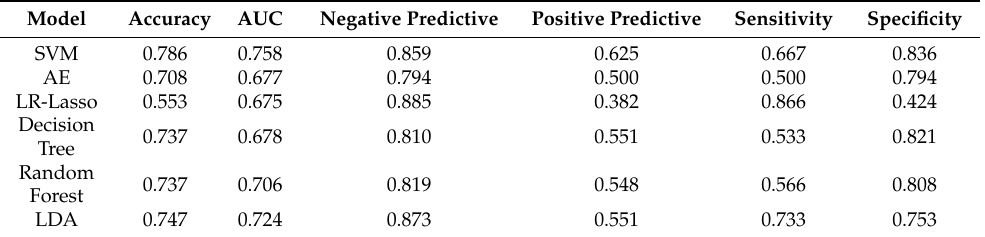
Table 3. Performance comparison of different